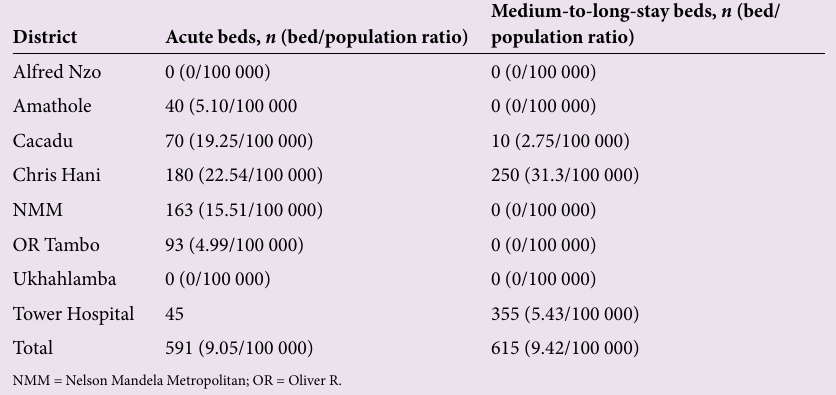
Table 2. Number of public sector psychiatric beds per region in the EC